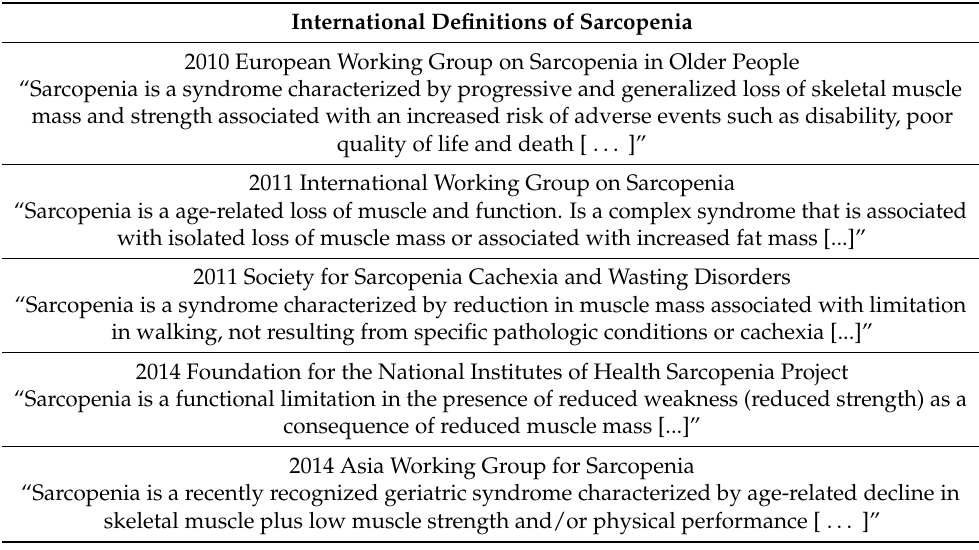
Table 1. Definitions and criteria of five major research group.